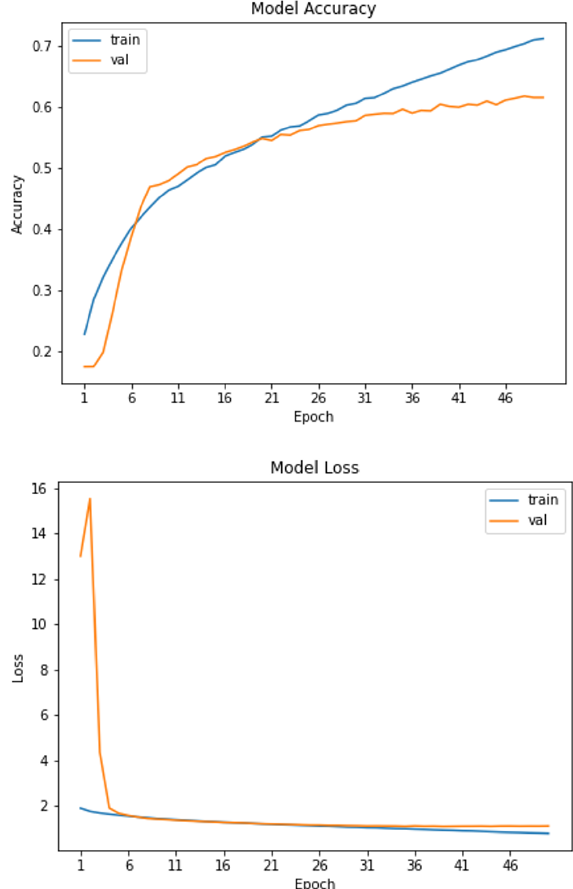
Fig. 6. Accuracy and loss curve after fine tuning ResNet50